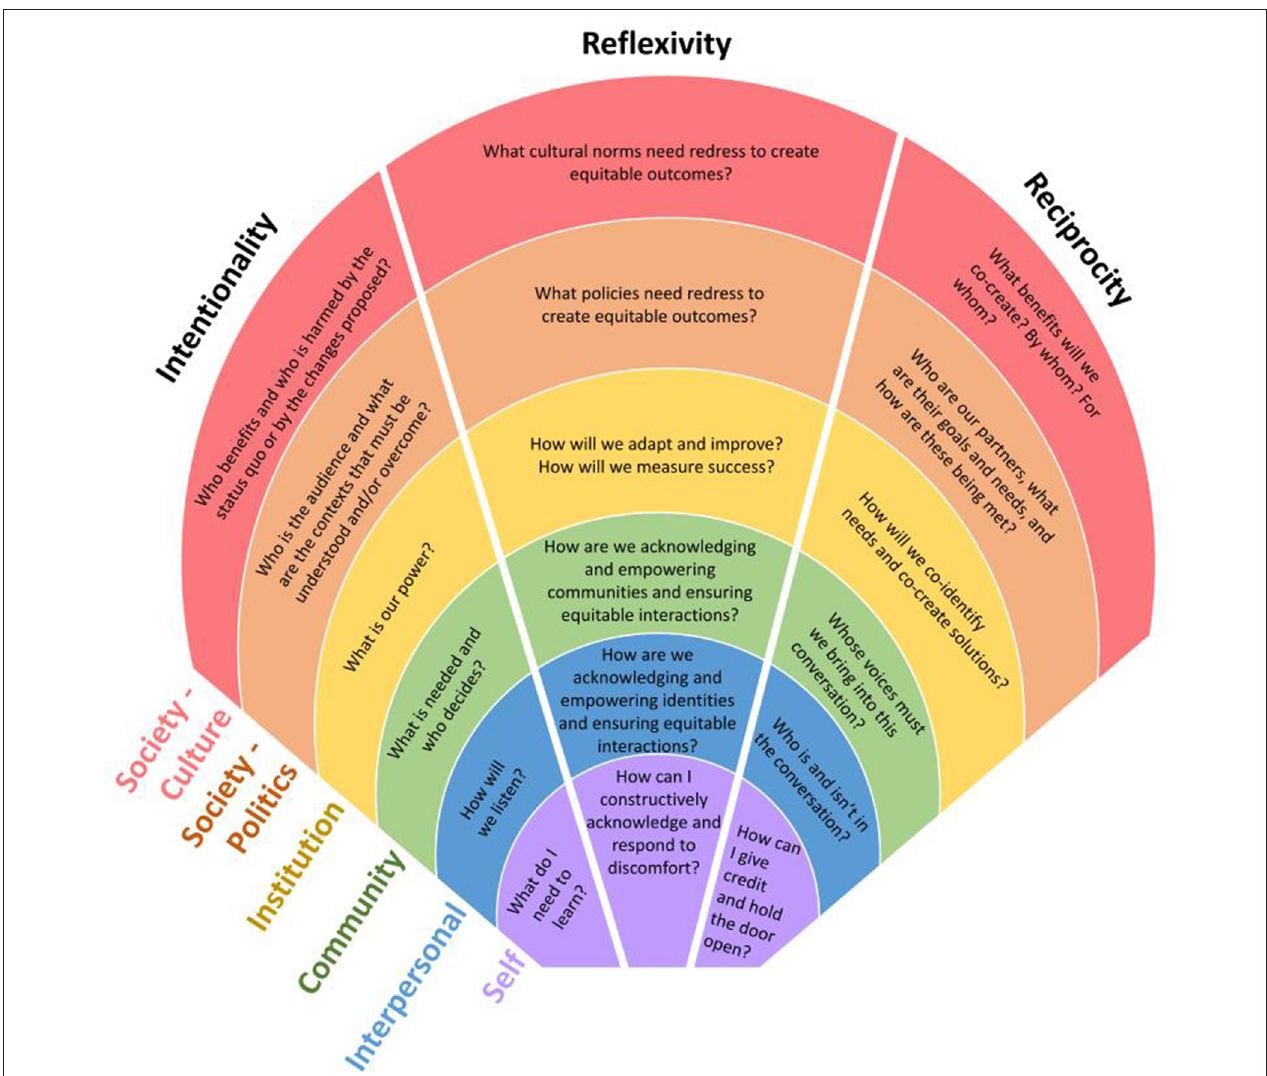
FIGURE 1 | Concept for co-creating a framework to guide authentic, culturally competent, and inclusive SciComm. In this figure, spheres of influence are represented as arcs of color, from self at center, to society-culture at the outer ring. The arcs are divided into three sections, each representing one of three traits of inclusive science communication (intentionality, reflexivity, and reciprocity) as marked at the top of each section. Each intersection of a sphere of influence and trait of Inclusive SciComm contains a question. Each question is a prompt to consider, for developing inclusive science communication trainings, workshops, and interactions. The draft prompts here are still in development and are intended as representative